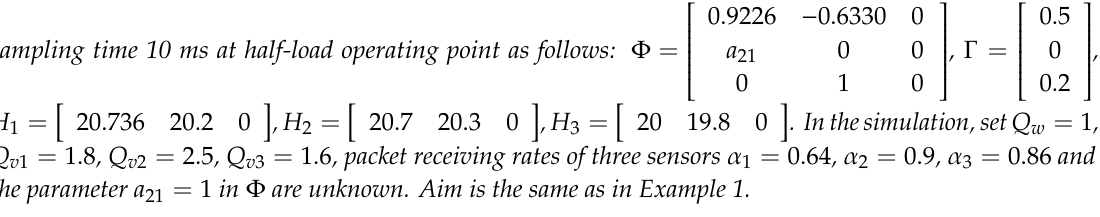
Figure 6. Comparison of MSEs of ST fusion filter and ST local filters: ( a ) The first state component; ( b ) The second state component.